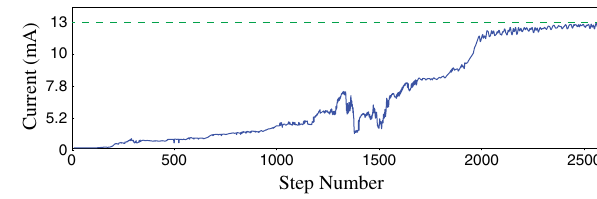
FIG. 4. The surviving current at the end of the beam transport over 2500 iteration steps is shown for an initial beam current of 13 mA.